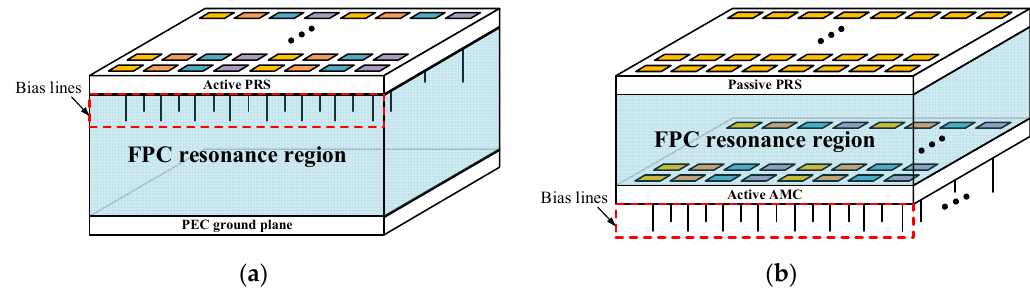
Figure 3. Overviews of FPC antennas consisting of ( a ) an active PRS and ( b ) an active AMC. It is desirable for the bias lines to be placed beneath the ground plane as they hardly affect the FP resonance in the cavity.